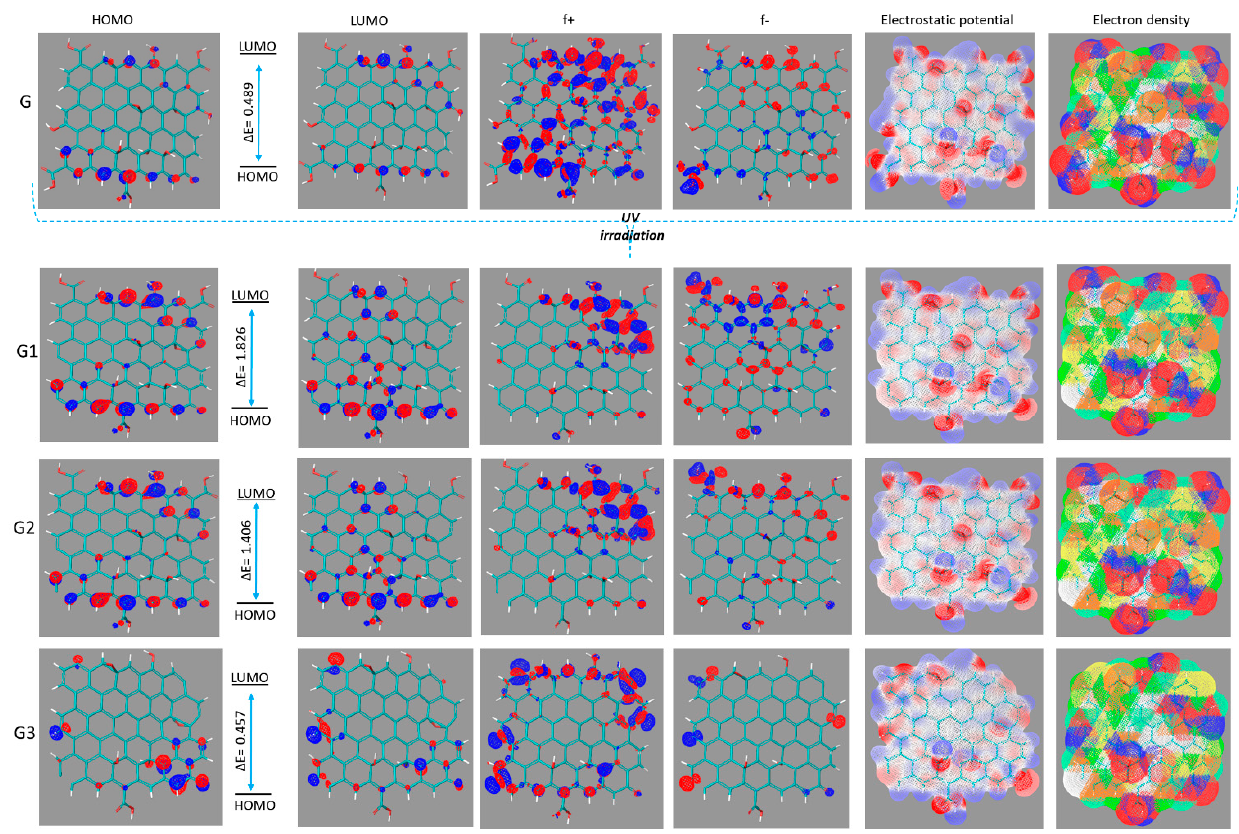
Figure 5. HOMO, LUMO orbitals, Fukui, electrostatic potential, and electronic density map of GON (G) and reduced GON forms (G1, G2, and G3).